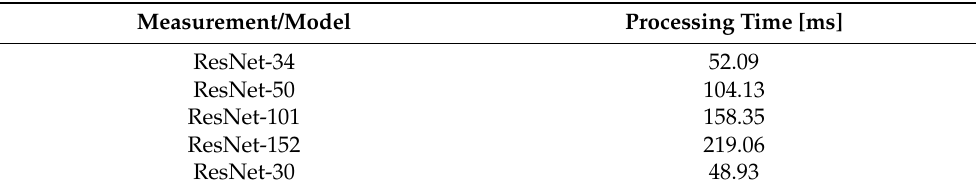
Table 6. The processing time (ms—millisecond) of Human detection for various ResNets. The calculation process is performed on a computer with the following configuration: GeForce GTX 1080 Ti GPU with Ubuntu OS installed in the system. The experiments are performed using the TensorFlow framework [68].